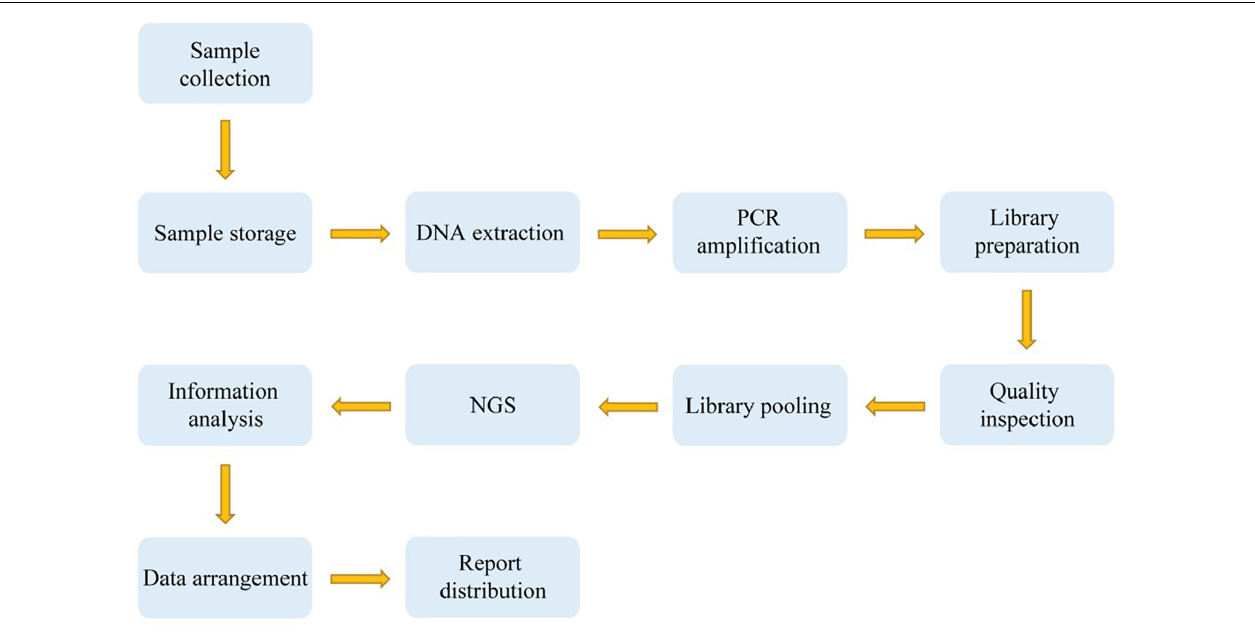
FIGURE 1 | A technical route of deafness genetic screening.